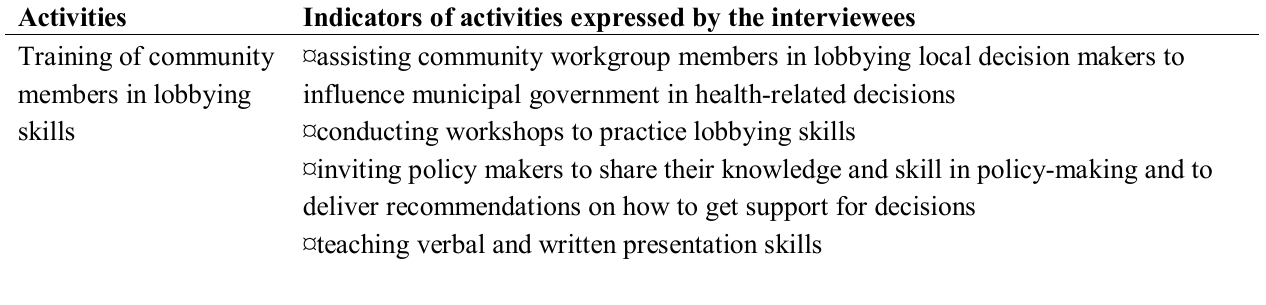
Table 7. Activities and indicators of activities expresses as empowering by the interviewees within the domain Creation of supportive